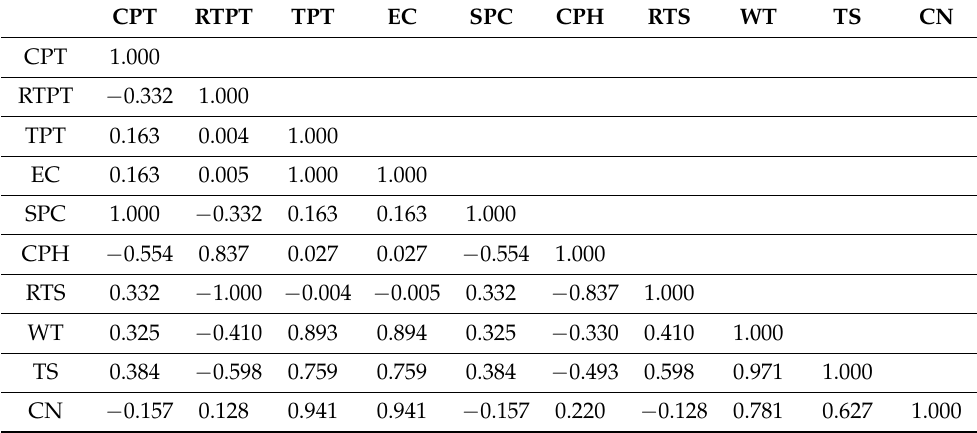
Table 3. Correlation